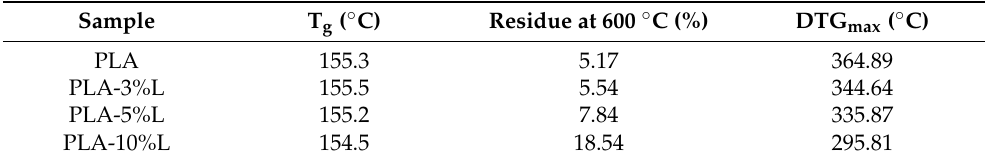
Figure 2. Chemical characterization by ( a ) FTIR and thermogram analysis of ( b ) DSC ( c ) TGA weight loss and ( d ) first derivative TGA analyses of extruded filament composites at different lignin compositions. Table 1. Glass transition temperature (T g ), sample residue percentages, and peak maximum decomposition rate filament composites.